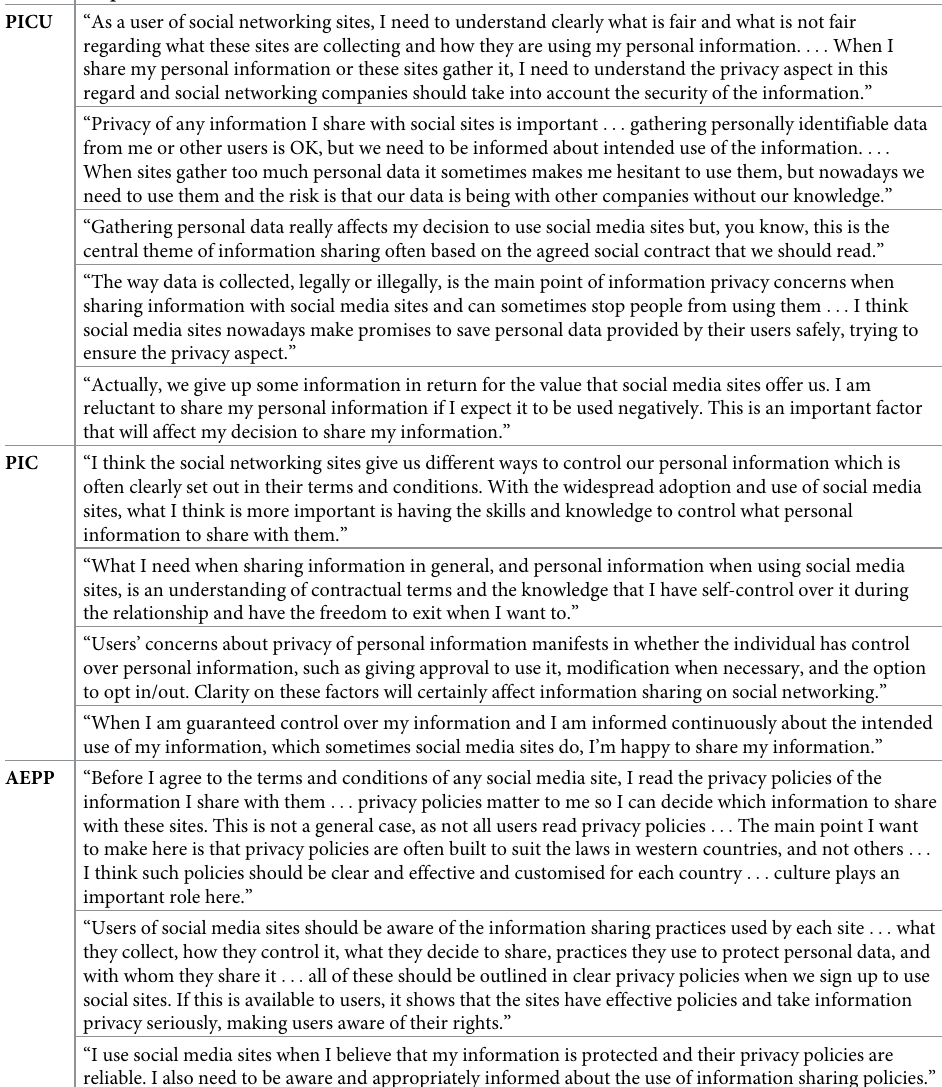
Table 2. Interviews’ main findings with respondent statements as